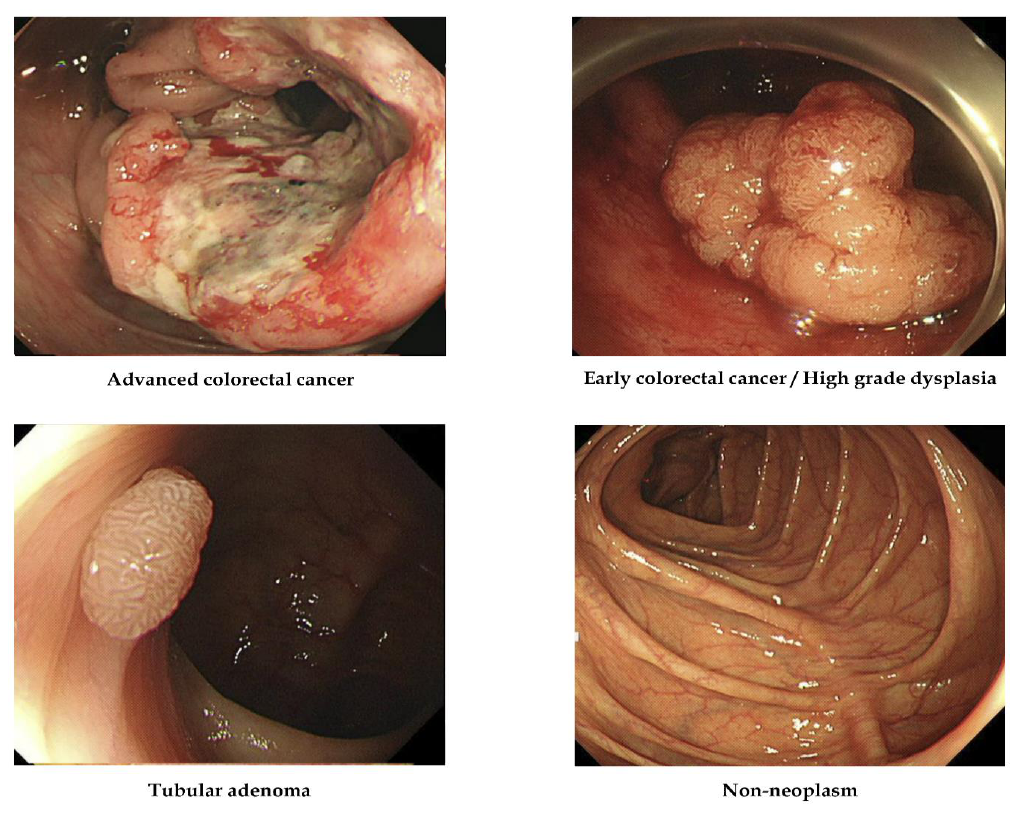
Figure 1. Representative images in each category used to establish artificial intelligence models. Representative examples of lesion images in each category are shown.